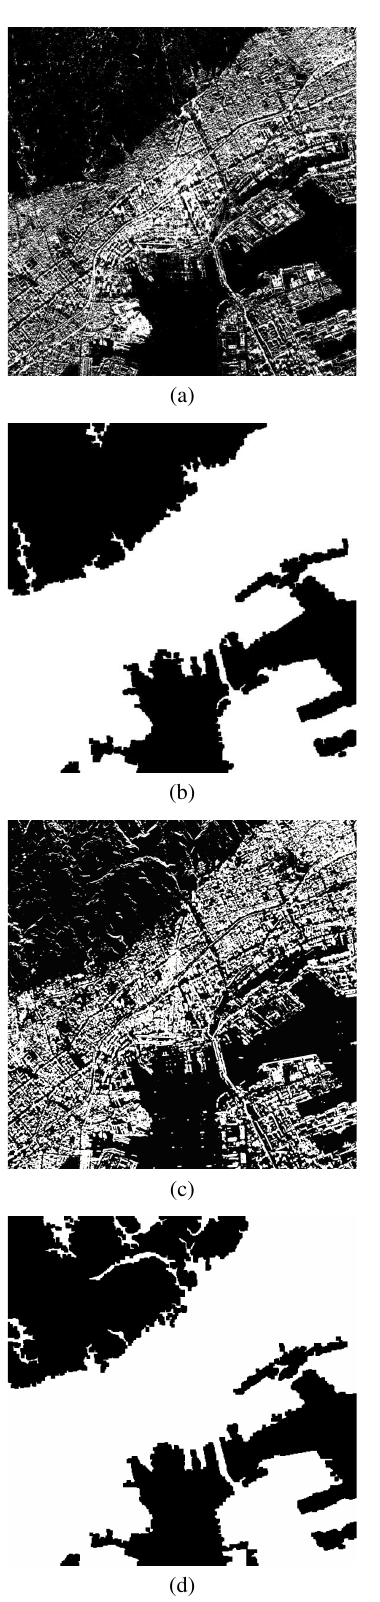
Figure 8. Comparison of classification results in study area 1. (a)(b) Results by using the proposed method before and after post-processing, respectively, and (c)(d) the result by using the method of Esch et al.(2013) before and after post-processing, re- spectively.